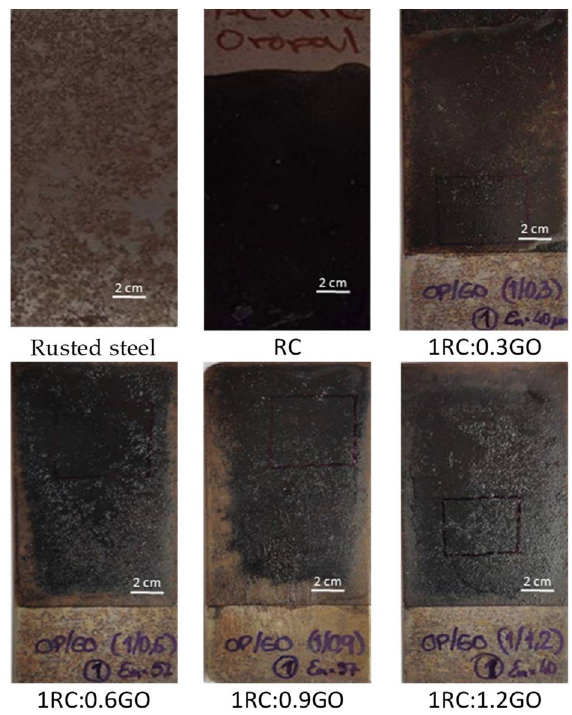
Figure 1. Pictures of rusted steel samples that were coated using the different RC:GO ratios, with 80 mm × 30 mm × 1 mm dimensions.